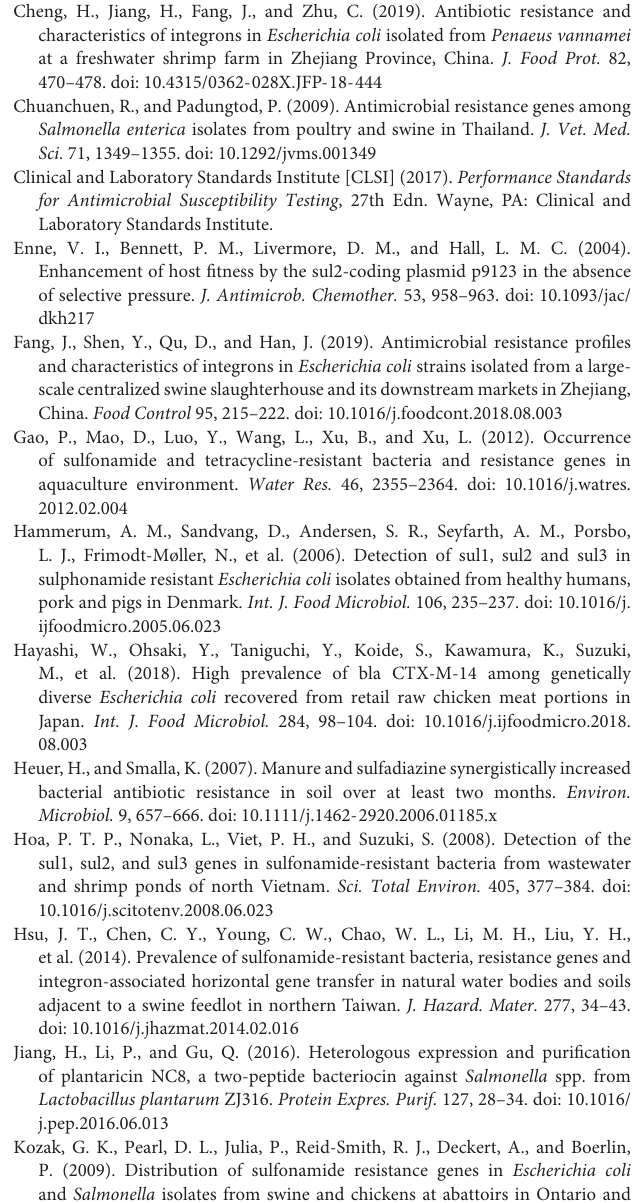
FIGURE S1 | Detection of sul genes in sulfisoxazole-resistant E. coli isolates (partial) by PCR. (A) detection of sul1 ; (B) detection of sul2 ; (C) detection of sul3 . M, DL2000 marker (100, 250, 500, 750, 1000, and 2000 bp). P, positive control; N, negative control; 1 − 21, sulfisoxazole-resistant E. coli isolates. FIGURE S2 | Southern blot analysis of the locations of sul genes in E. coli isolates. (A) Analysis of the location of sul1 . 1, chromosomal DNA of 1PO-01 isolate; 2, plasmid DNA of 1PO-01 isolate; 3, chromosomal DNA of 2PO -57 isolate; 4, plasmid DNA of 2PO-57 isolate; 5, chromosomal DNA of 3PO-15 isolate; 6, plasmid DNA of 3PO-15 isolate; 7, chromosomal DNA of 1PO-20 isolate; 8, plasmid DNA of 1PO-20 isolate. (B) Analysis of the location of sul2 . 1, plasmid DNA of 1PV-01 isolate; 2, plasmid DNA of 2PV-19 isolate; 3, plasmid DNA of 3PV-52 isolate; 4, plasmid DNA of 1PV-38 isolate; 5, plasmid DNA of 2PV-22 isolate; 6, plasmid DNA of 3PV-15 isolate; 7, plasmid DNA of 3PV-24 isolate. (C) Analysis of the location of sul3 . 1, chromosomal DNA of 1PO-58